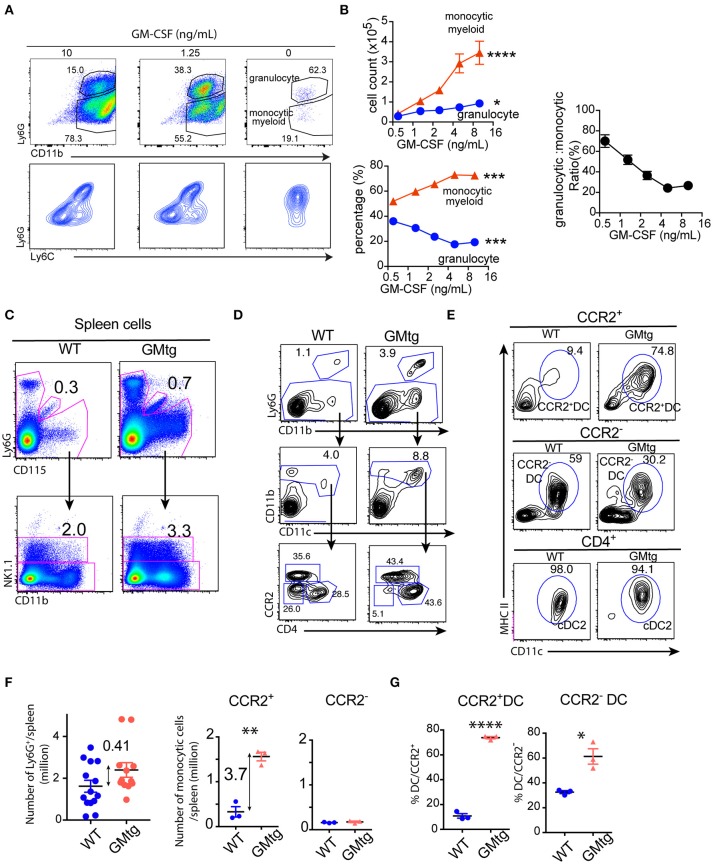
The effect of GM-CSF dose on generation of granulocytic vs. monocytic myeloid cells. BM cells were cultured in the presence of different doses of GM-CSF for 7 days. Cultures were harvested and analyzed for cell composition. (A) FACS plots show profiles of Ly6Ghi granulocytes and Ly6GloCD11bhi monocytic myeloid cells on gated PI−CD11b+ cells. (B) Plots show the recovered cell number and percentage of granulocytes and monocytic myeloid cells with different doses of GM-CSF. *p < 0.05, ***p < 0.001, ****p < 0.0001 (ANOVA). Data are from one of 3 repeated experiments. Plot on the right shows the ratio of granulocyte to monocytic myeloid cells in the cultures with different doses of GM-CSF. (C–G) Spleen cells of WT (including CCR2.CFP.DTR mice) and GMtg mice (including CCR2.CFP.DTR/GMTg mice) were prepared and stained for myeloid markers. (C) autofluorescent macrophages and NK1.1+ cells were gated out for analysis of CD11b+ cells; (D) within CD11b+ cells, granulocytes were gated as Ly6G+ cells; Ly6G− cells were then separated into three populations: CD11b+ CD4+ cDC2, CCR2+ and CCR2− cells; (E) Three populations are shown for expression of CD11c and MHC class II. (F) Scatter plots show the number of granulocytes (pooled from 4 independent experiments) and monocytic myeloid cells (from one of 4 similar experiment). Numbers in the plots show fold increase. **p < 0.01 (G) CCR2+ and CCR2− cells are shown for the percentages of DCs. *p < 0.05, ****p < 0.0001 (student's t-test).